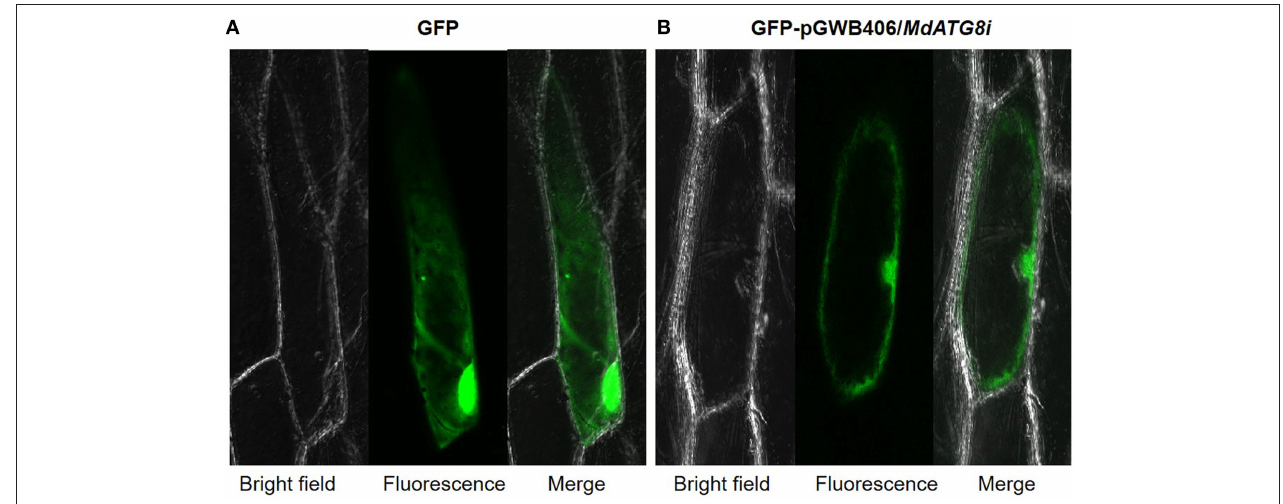
FIGURE 5 | Subcellular localization analysis of MdATG8i in onion epidermal cells. (A) GPF control; (B) MdATG8i-GFP fusion protein.